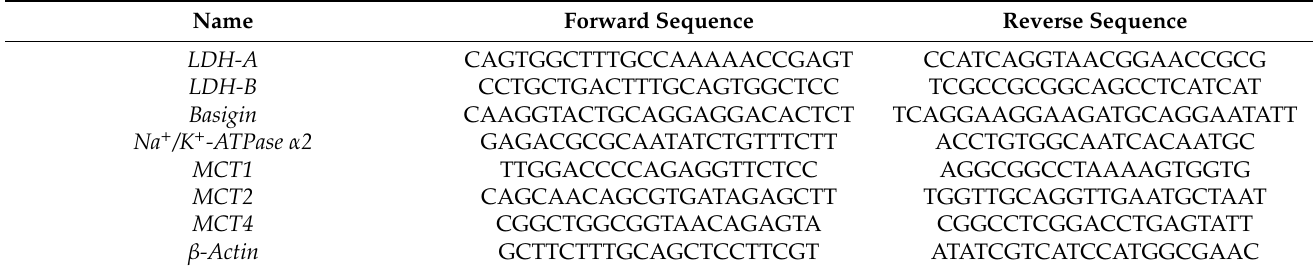
Table 1. List of primer sequences used in qRT-PCR